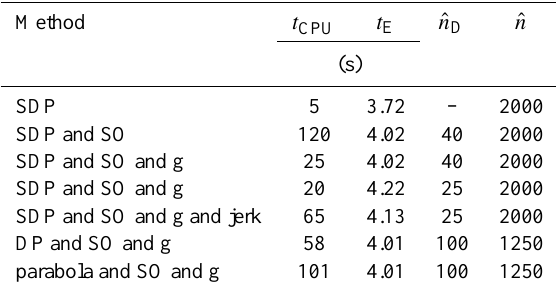
Table 1. Trajectory execution times t E and calculation times t CPU for the different